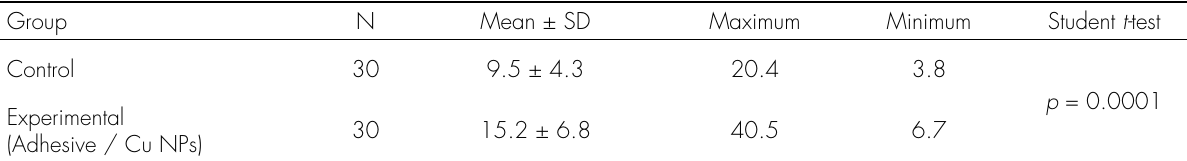
Table II. Values of shear bond strength expressed in